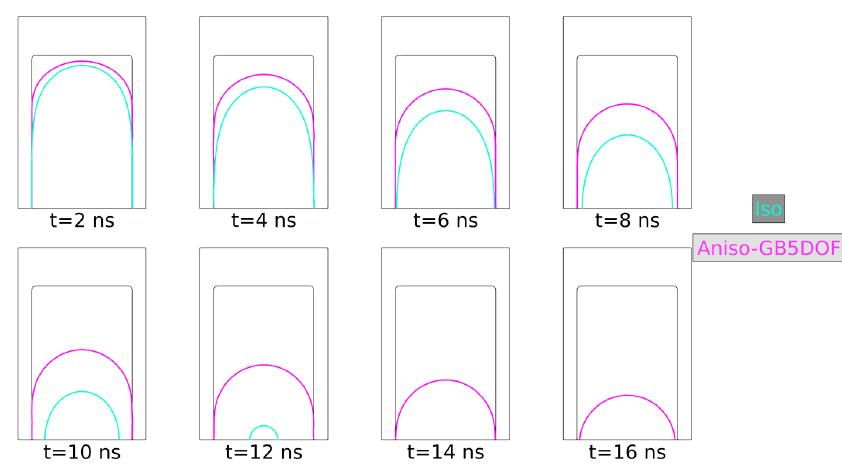
Figure 23. Interface evolution at different times, t = 2, 4, 6, 8, 10, 12, 14, 16